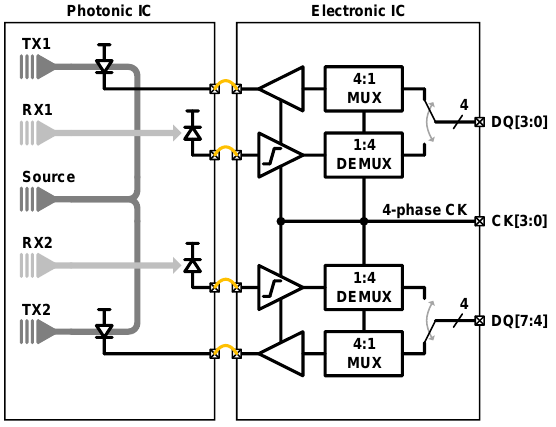
Figure 12. Block diagram of optical transceiver [51].